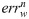
The error and its assignment in our algorithm.The error err is assigned to two parts, among which errwn is assigned to the current layer for weight modification, and errtn is propagated to previous (n − 1) layers.